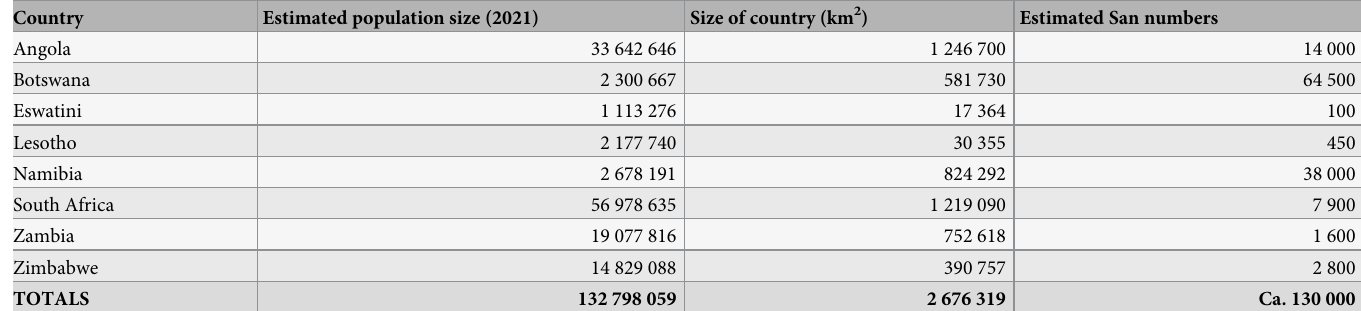
Table 2. Estimated number of San population sizes in Angola, Botswana, Eswatini, Lesotho, Namibia, South Africa, Zambia, and Zimbabwe. Data obtained from the Southern African Development Community (SADC); The World Factbook (2021), Ethnologue (www.ethnologue.com); fieldwork observations and Nyae Nyae Develop- ment Foundation of Namibia (NNDFN), Nyae Nyae Conservancy (NNC), Namibia; Legal Assistance Centre (LAC), Namibia; Desert Research Foundation of Namibia (DRFN), Namibia; Botswana Khwedom Council (BKC), Botswana; First People of the Kalahari (FPK), Botswana; the San Youth Network (SyNET), Botswana; the National